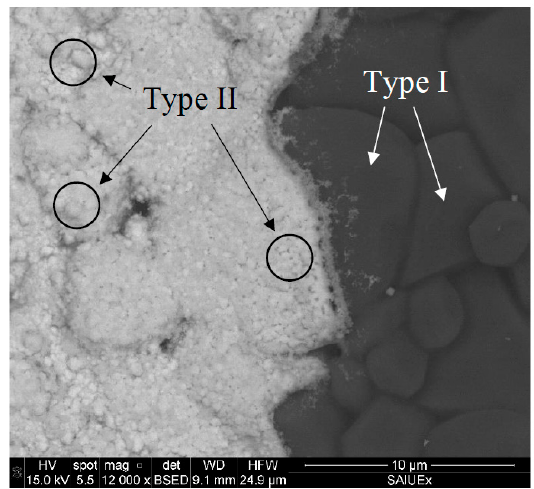
Figure 5. SEM image of a commercial Bi SP SPE: The boundary between the sputtered bismuth covering the working electrode and the bare supporting alumina substrate.